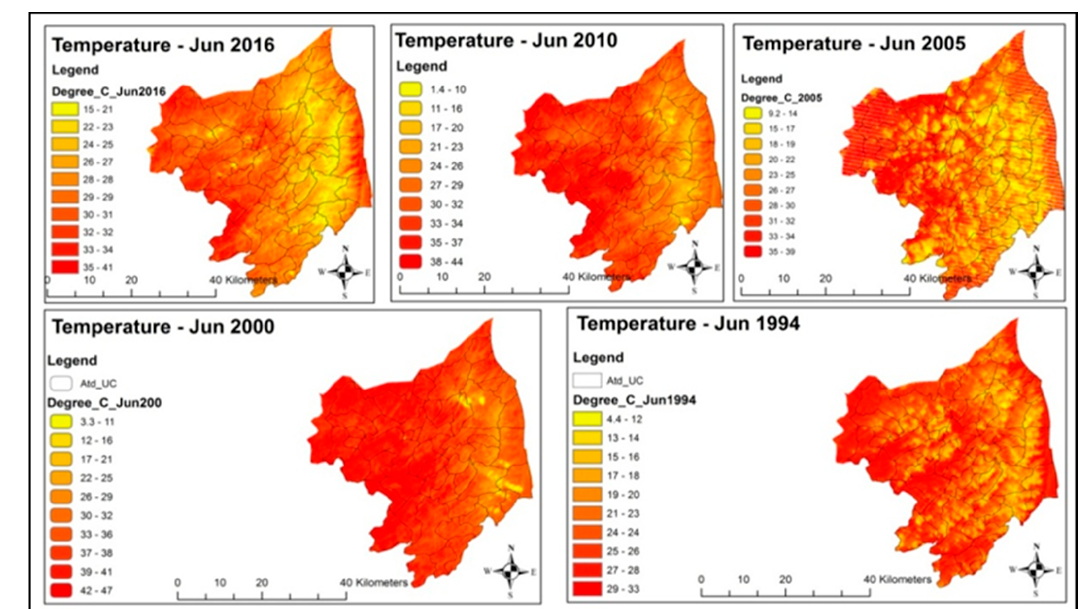
Figure 13. LST of Abbottabad at a Glance from Jun 1990–Jun 2016.